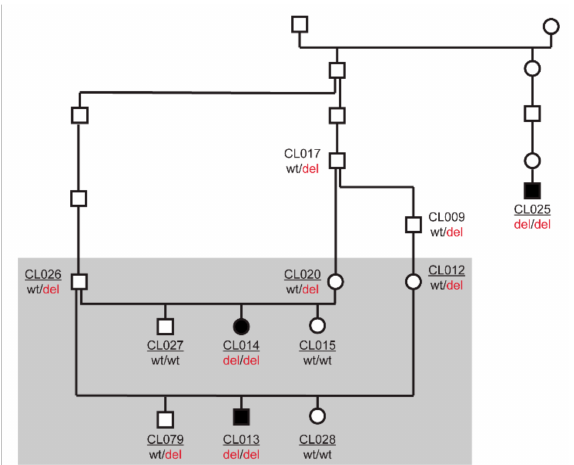
Figure 1. Pedigree of the three investigated cases. Filled symbols represent dogs with recurrent inflammatory pulmonary disease. Open symbols represent non-a ff ected dogs.